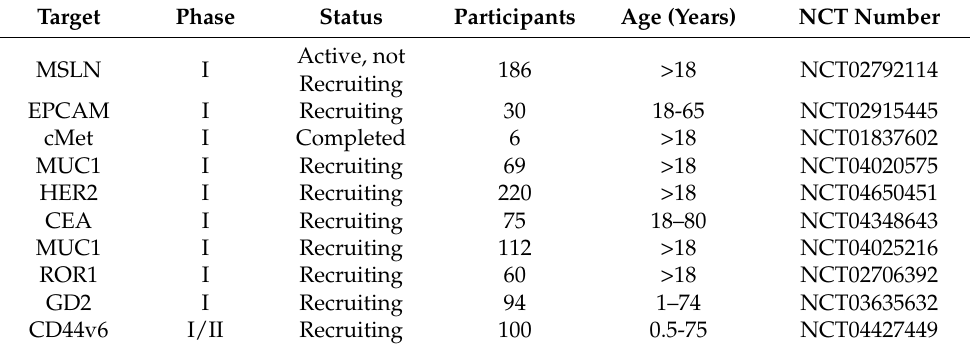
Table 4. Clinical trials of CAR-T cell immunotherapy for breast